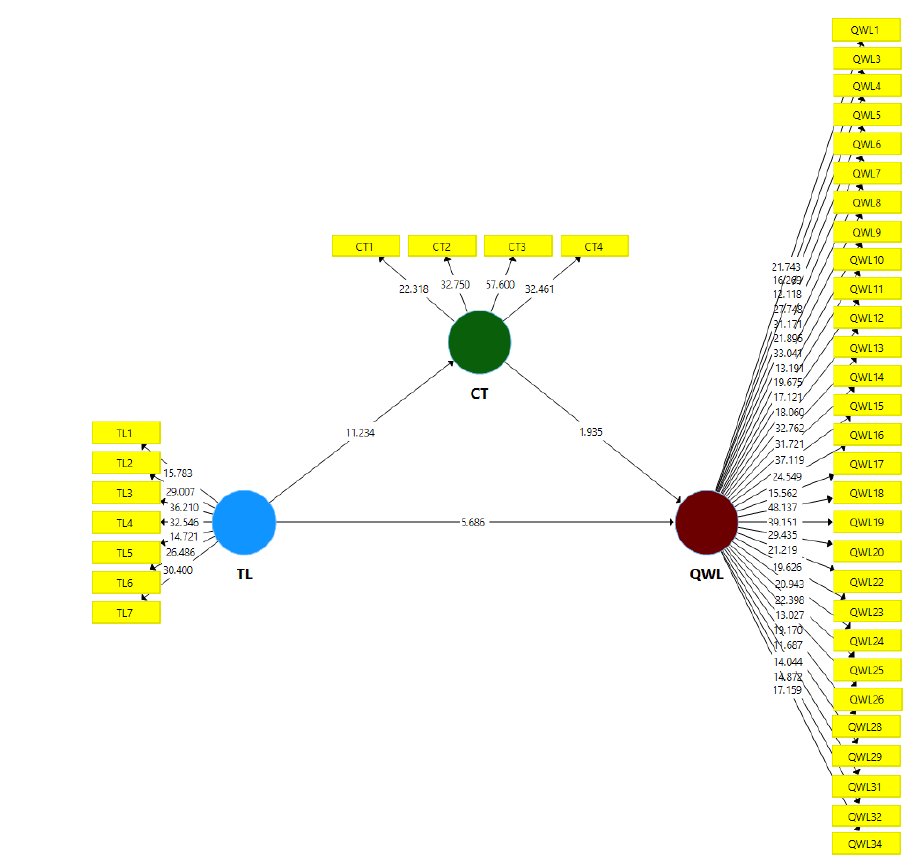
Figure 3. Bootstrapping